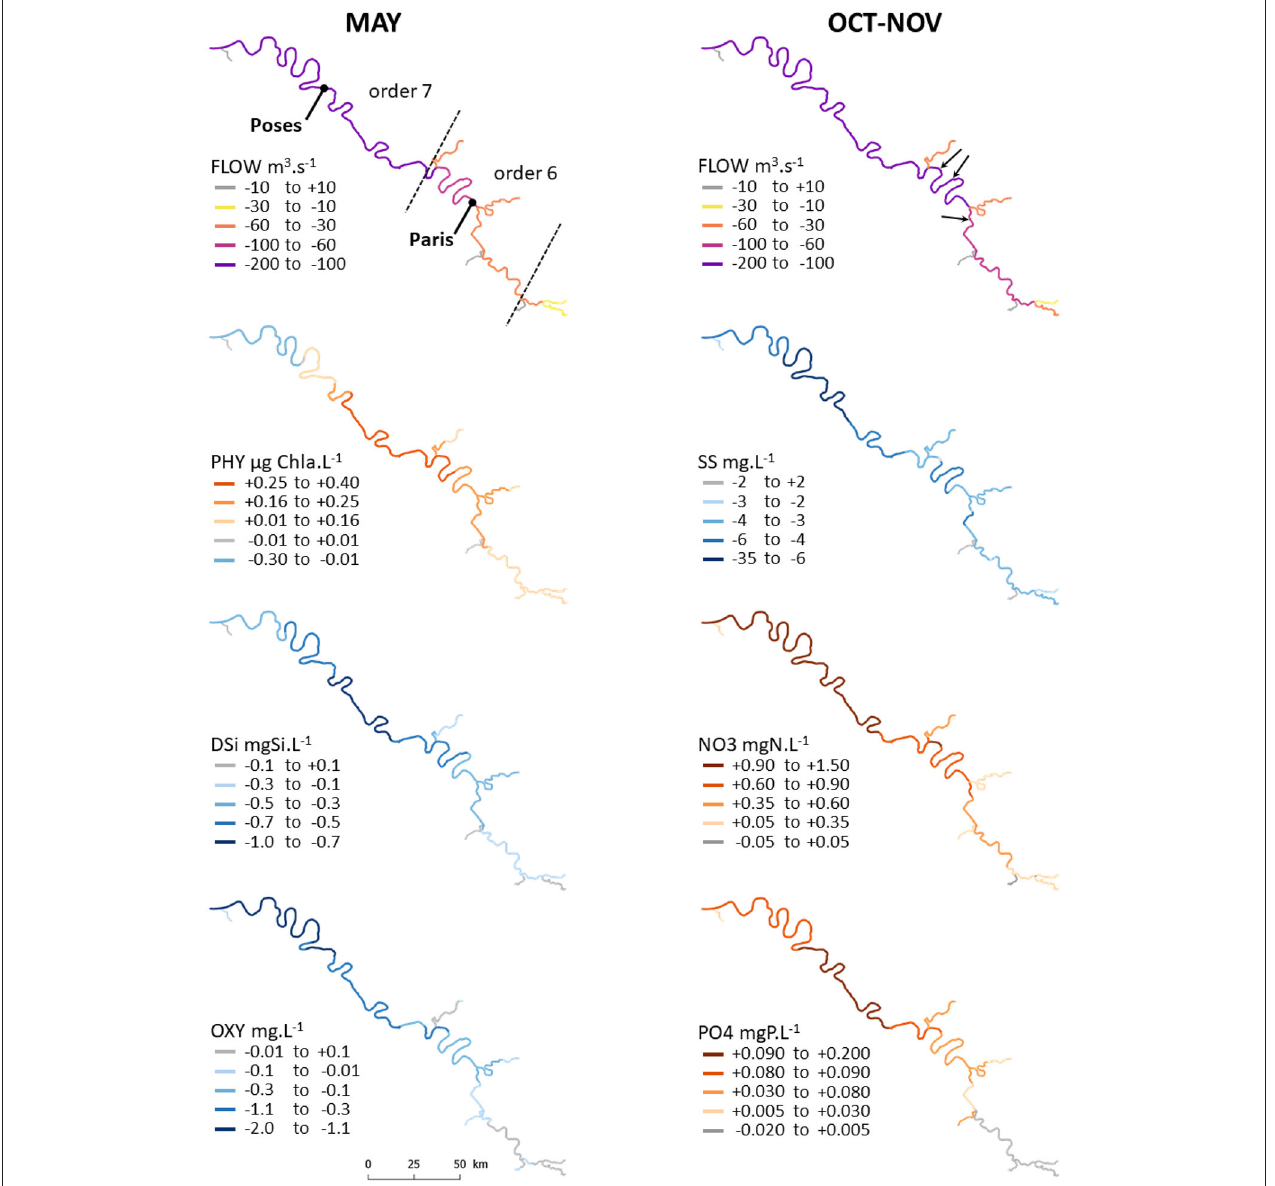
FIGURE 8 | Maps of climate change impacts on hydro-biogeochemical variables along the main Seine River network before Paris until the river estuary in May (left) and October/November (right) for the driest scenario, RCP8.5 (ICHEC85_CLMcom). Absolute differences between the 2080–2100 period and the 1980–2000 reference period. Dashed lines indicate changes in Strahler order (top left) ; arrows show major waste water treatment plants around Paris (top right)